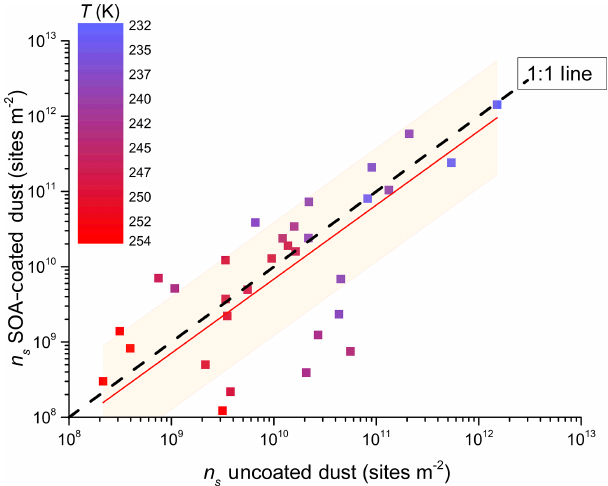
Figure 10. Same as Fig. 8 but binned by temperature into 1K bins not accounting for cloud chamber type as a function of temperature. Error bars omitted for clarity of temperature colour bar. Dashed line is 1:1 fit and red line is linear fit to data n s ( coated ) = n s (uncoated) with forced intercept (0,0) with r 2 = 0 . 99. Shaded region represents 66% prediction bands of